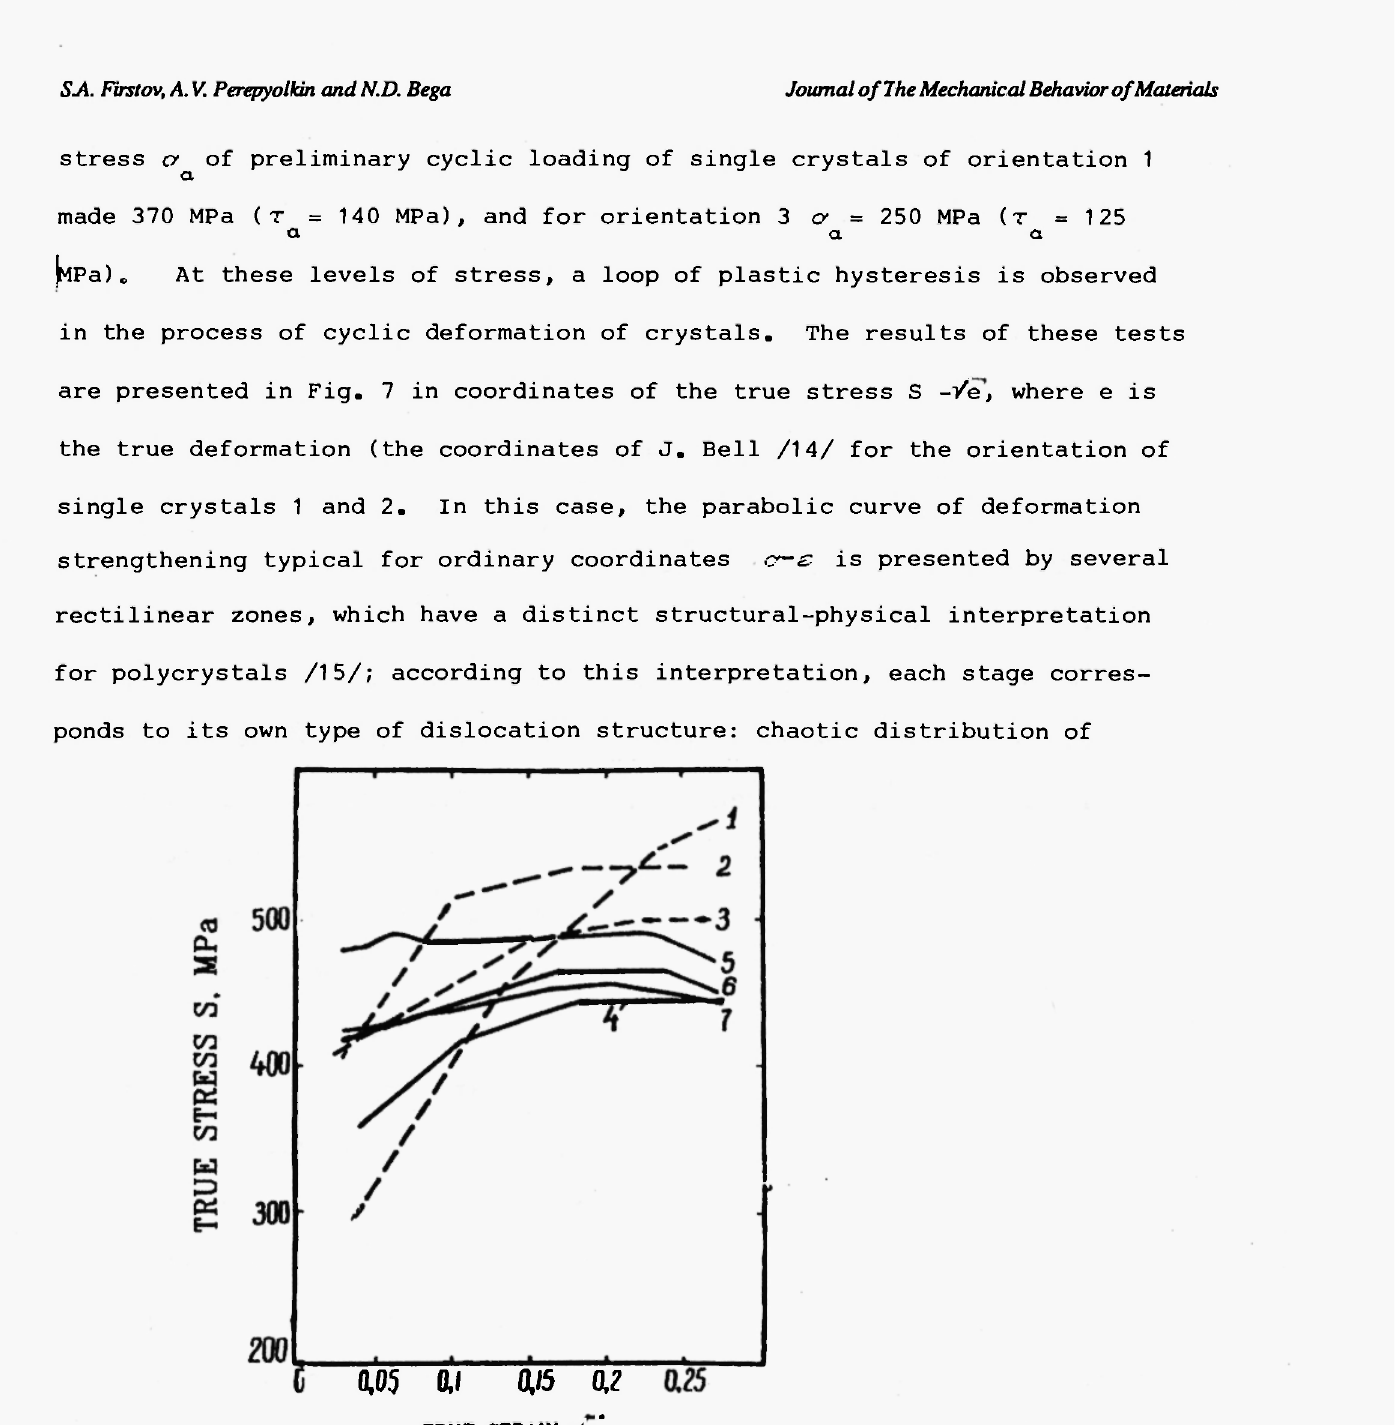
Influence of the preliminary cyclic on tension diagrams in the coordinates